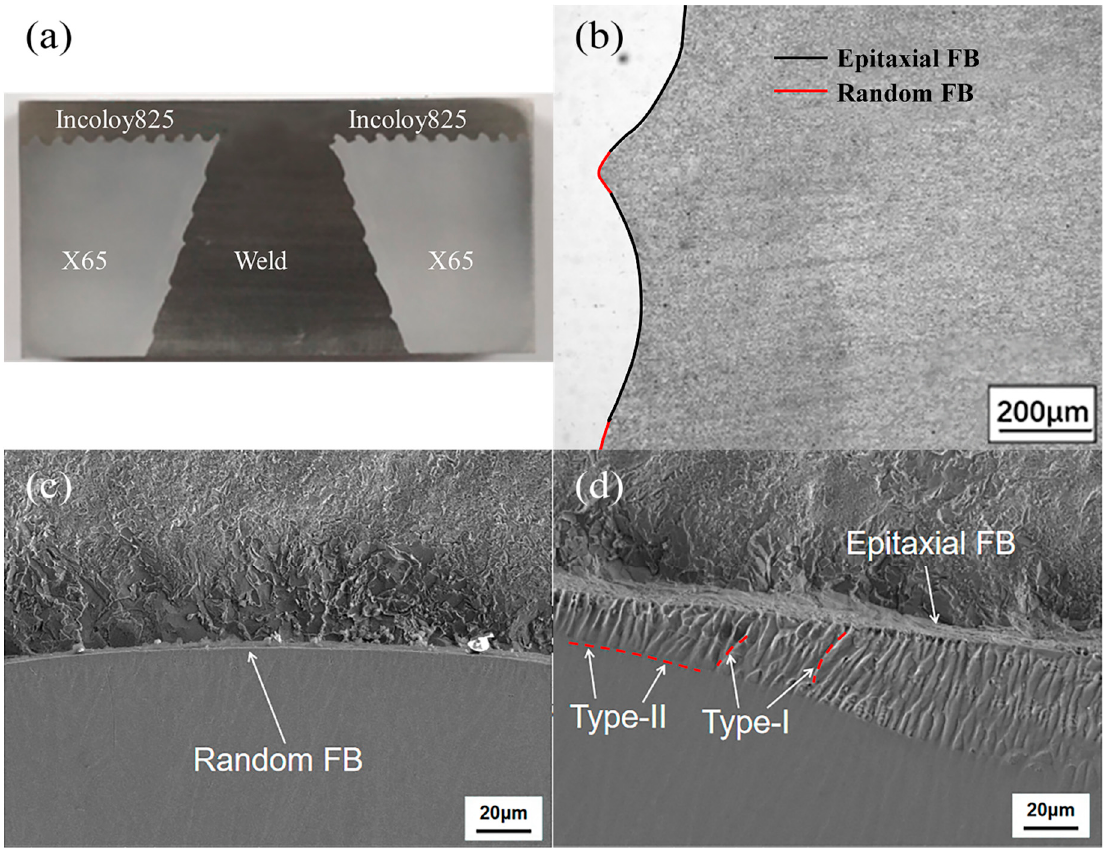
Figure 4. Microstructure diagram of the welded joint of the bimetallic composite pipe: ( a ) macroscopic schematic diagram; ( b ) microstructure diagram; ( c ) random FB; ( d ) epitaxial FB. Figure 5 is the inverse pole figure (IPF) diagram of the intersection of the three